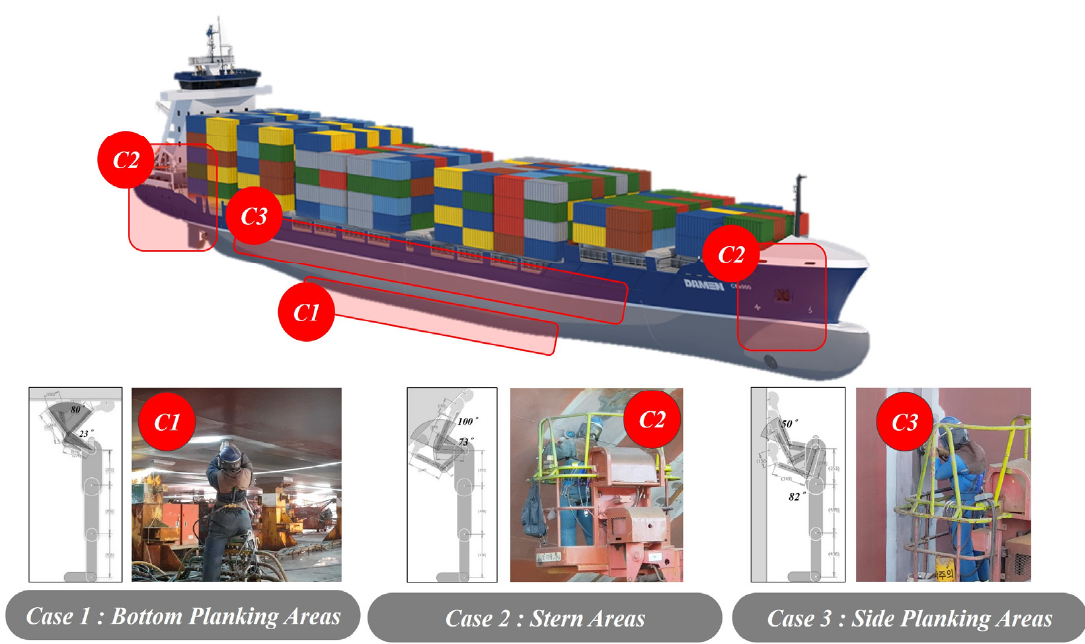
Figure 1. Various working motions in shipyard by section: C1 is bottom planking areas(Case 1), C2 is stern areas(Case 2), C3 is side planking areas(Case 3)